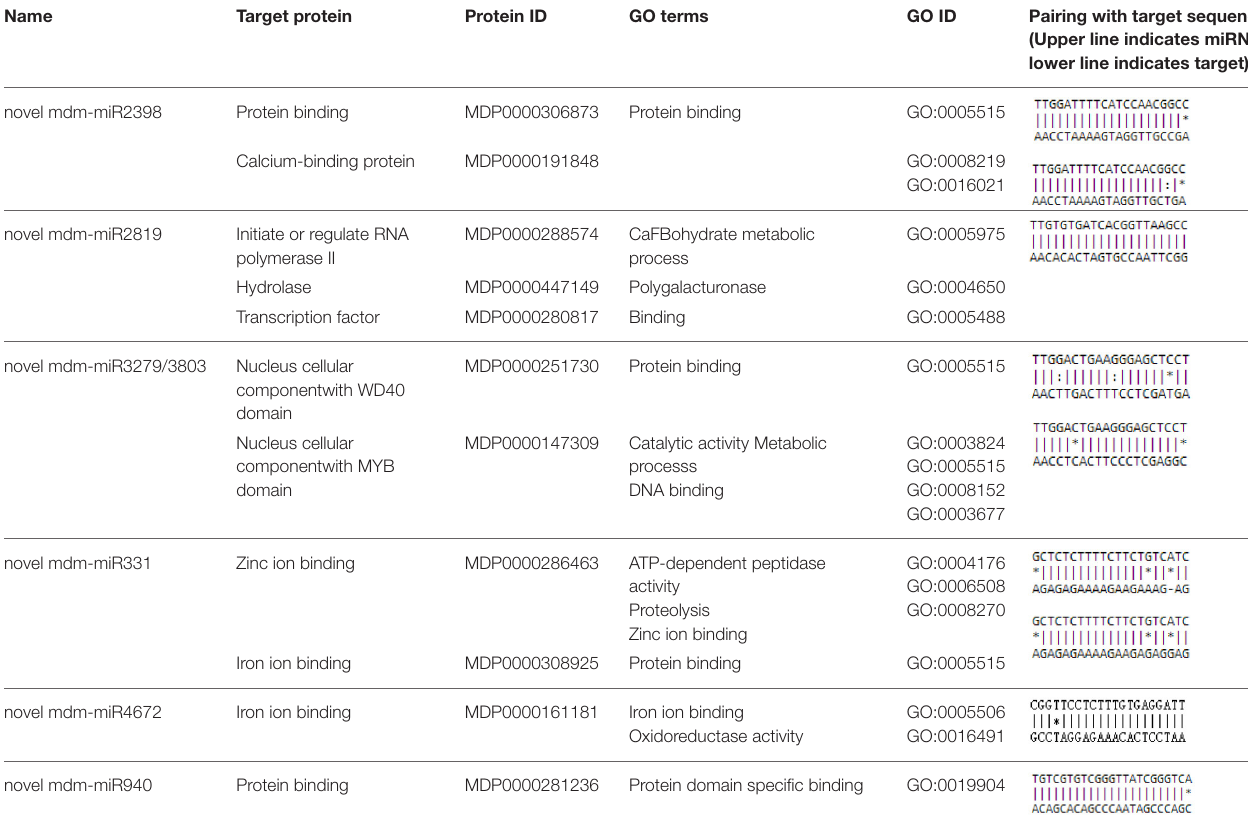
TABLE 3 | GO analysis of potential targets of novel miRNAs during floral transition from Malus domestica . Name Target protein Protein ID GO terms GO ID Pairing with target sequence